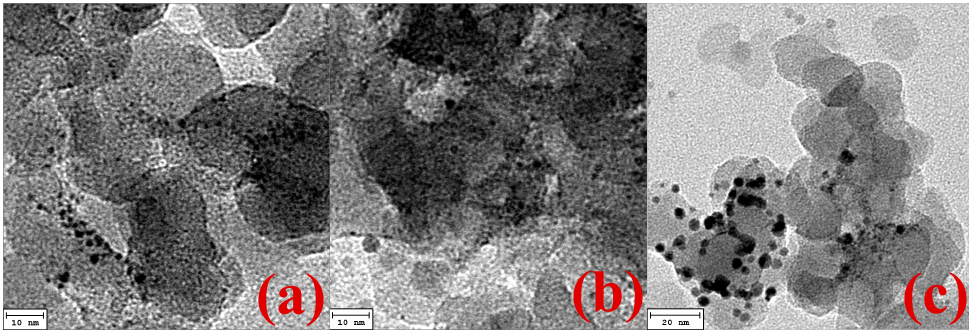
Figure 9. TEM images for Pt cluster deposited on ( a ) Pt/ NaY-SiO 2 , ( b ) PtR (HF) , ( c ) PtR (LF) . A normal k 2 (2.68 < k < 14.3 Å − 1 )-weighted Fourier transformation without correction